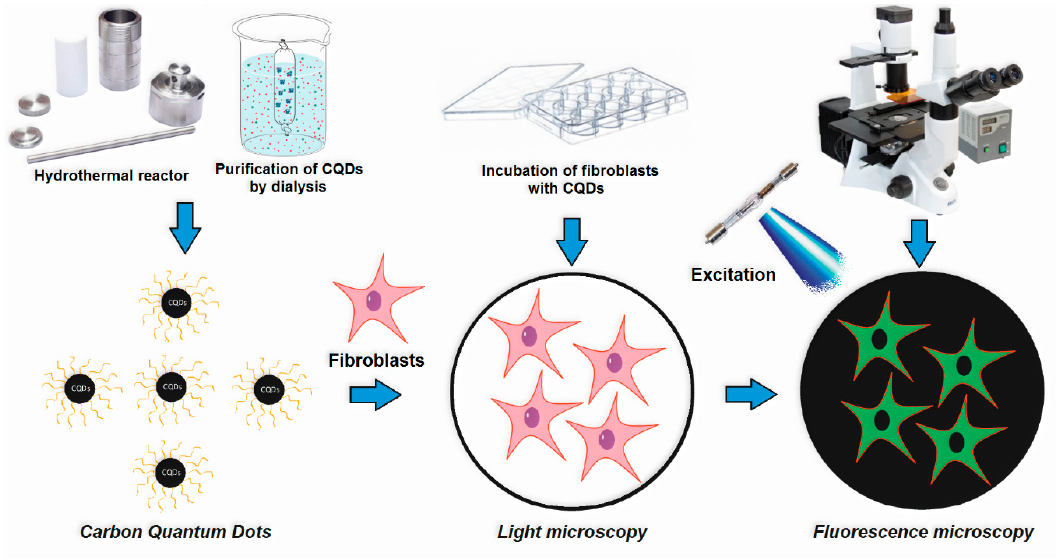
Figure 1. General strategy for the carbon quantum dot’s (CQD’s) preparation and application.